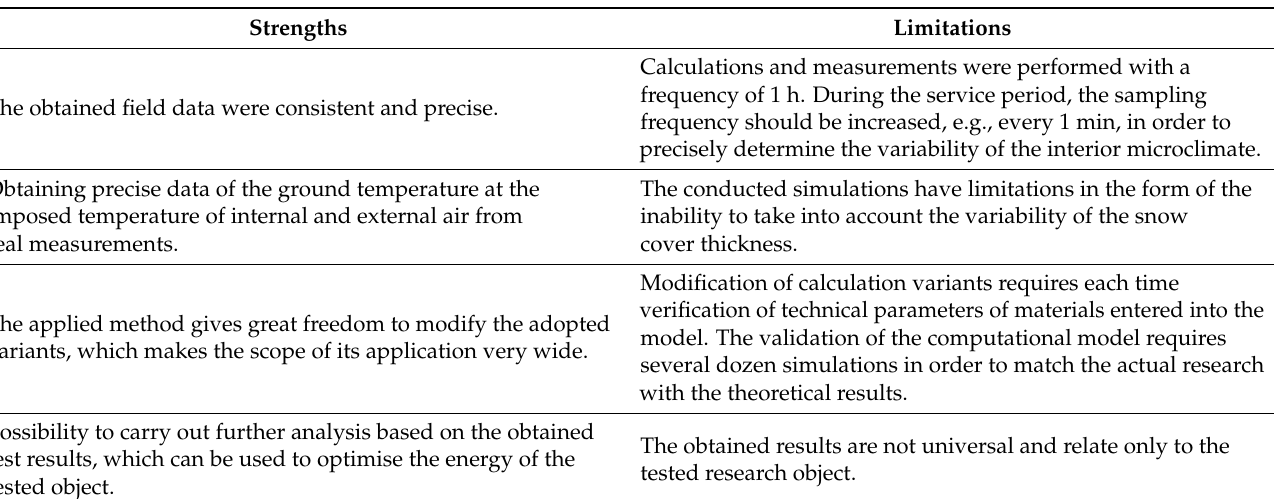
Table 2. Strengths and limitations of